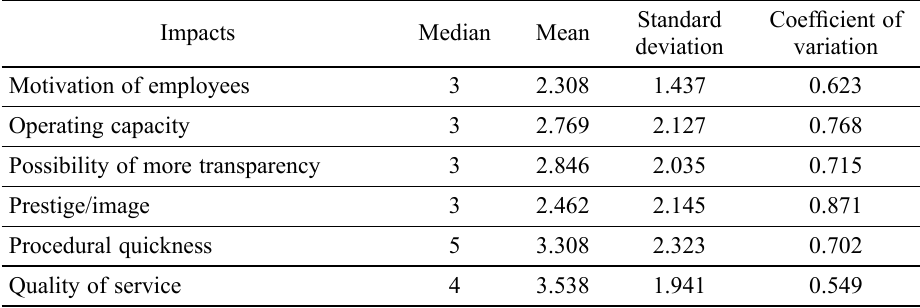
Table 6. Main impacts of new technologies in the competitive advantage of the municipality Impacts Median Mean